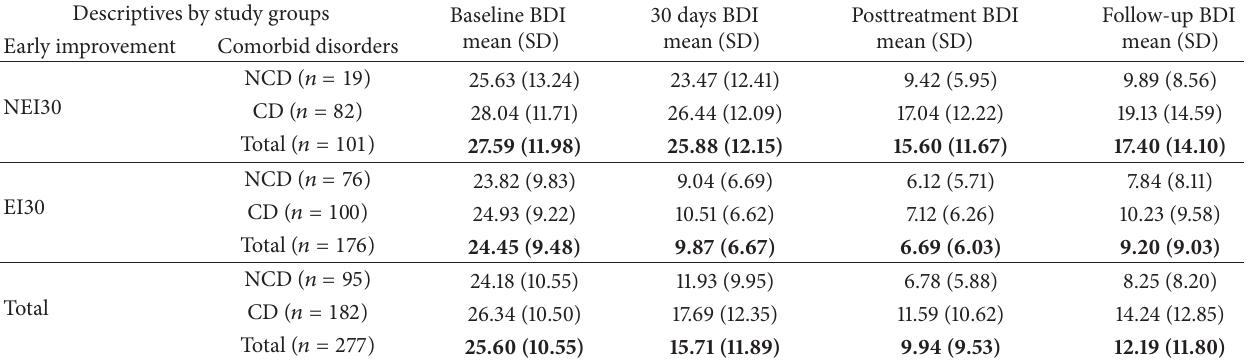
Table 4: Descriptives by study group and time of